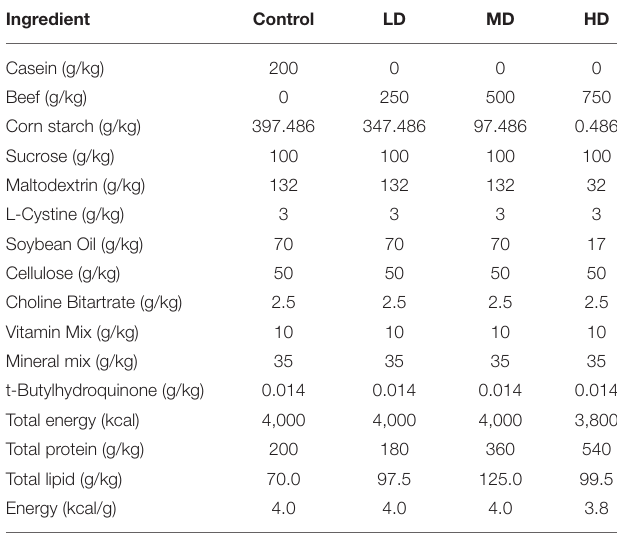
TABLE 1 | Composition of different levels of red meat